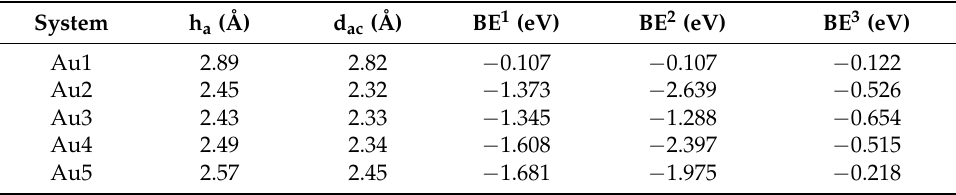
Figure 3. Stable geometries of Au clusters adsorbed on perfect graphene. Au 1 –Au 5 and Au 5 (P) clusters are shown from top to bottom rows. Left and right columns show top and side views, respectively. Reproduced from Reference [92] with permission from the American Physical Society. Table 2. Anchor atom’s distance above graphene plane (h a ), distance from nearest-neighbor C atom (d ac ), binding energies (BE 1 –BE 3 ) of Au n clusters adsorbed on perfect graphene. Reproduced from Reference [92] with permission from the American Physical Society.